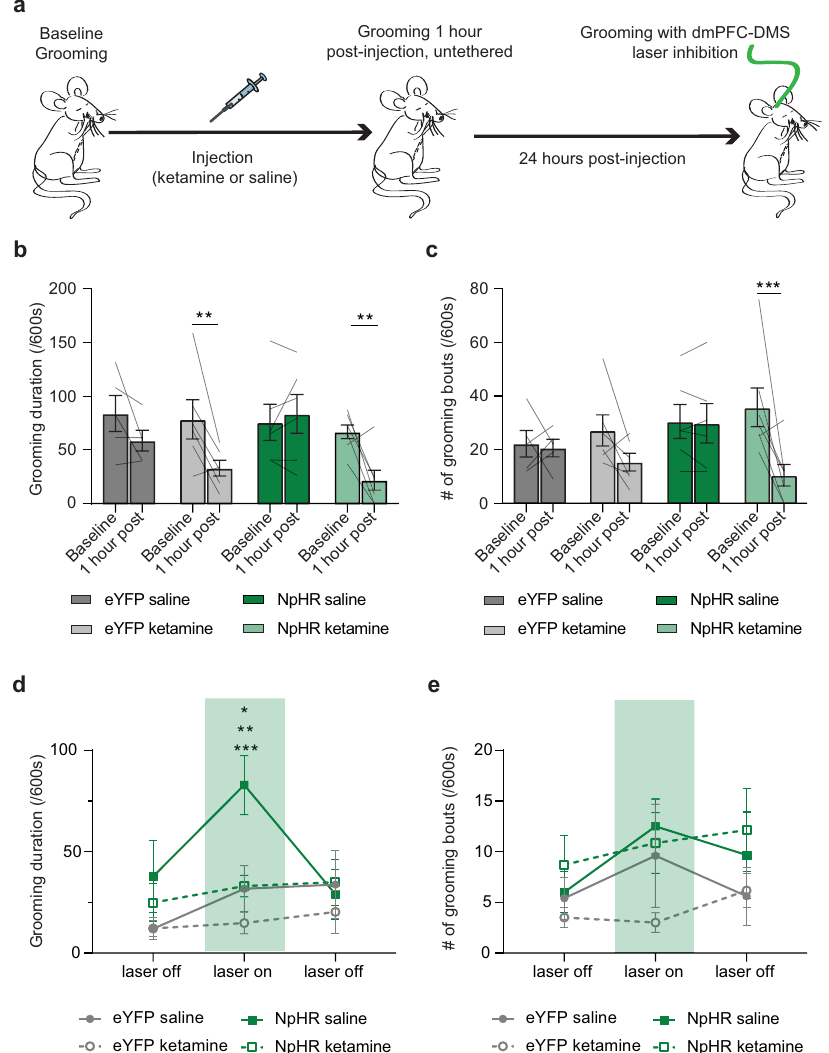
Fig. 7 Ketamine blocks grooming increase caused by inhibition of dmPFC-DMS projections in SAPAP3 KO mice. Bar and line graphs show data means + / − SEM. Black lines on bar graphs represent individual animals. Lines start and stop at individual animal ’ s average for that graph ’ s conditions. Source data are provided as a Source data fi le. * P < 0.05, ** P < 0.01, *** P < 0.001. a SAPAP3 KO with bilateral implants in the DMS expressing either eYFP or eNpHR3.0 in the dmPFC are injected with either saline or ketamine followed by grooming measurements. b Ketamine reduces grooming duration 1-h post-injection (two-way RM ANOVA: interaction P = 0.0181, treatment P > 0.05, time P = 0.0003, subject P = 0.0027; Sidak ’ s multiple comparisons: ketamine KO-eYFP baseline vs 1-h P = 0.0061, ketamine KO-NpHR baseline vs 1-h P = 0.0033; saline KO-eYFP = 5, ketamine KO-eYFP = 6, saline KO- NpHR = 6, ketamine KO-NpHR = 7). c Only SAPAP3 KO-NpHR that receive ketamine show a signi fi cant reduction in grooming frequency 1-h post- injection (two-way RM ANOVA: interaction P = 0.0278, treatment P > 0.05, time P = 0.0045, subject P = 0.0260; Sidak ’ s multiple comparisons: ketamine KO-NpHR baseline vs 1-h P = 0.0009; saline KO-eYFP = 5, ketamine KO-eYFP = 6, saline KO-NpHR = 6, ketamine KO-NpHR = 7). d Inhibition of dmPFC- DMS projections signi fi cantly increases grooming in SAPAP3 KO-NpHR mice injected with saline (two-way RM ANOVA: interaction P = 0.0221, laser P = 0.0167, treatment P = 0.0612, subject P = 0.0037; Tukey ’ s multiple comparisons: saline KO-eYFP vs saline KO-NpHR P = 0.0147, ketamine KO-eYFP vs saline KO-NpHR P = 0.0003, ketamine KO-NpHR vs saline KO-NpHR P = 0.0086; saline KO-eYFP = 5, ketamine KO-eYFP = 6, saline KO-NpHR = 6, ketamine KO-NpHR = 7). e Neither inhibition of dmPFC-DMS projections nor drug treatment affectgrooming frequency (two-way RM ANOVA: interaction P > 0.05, laser P > 0.05, treatment P > 0.05, subject P = 0.0004; saline KO-eYFP = 5, ketamine KO-eYFP = 6, saline KO-NpHR = 6, ketamine KO-NpHR =